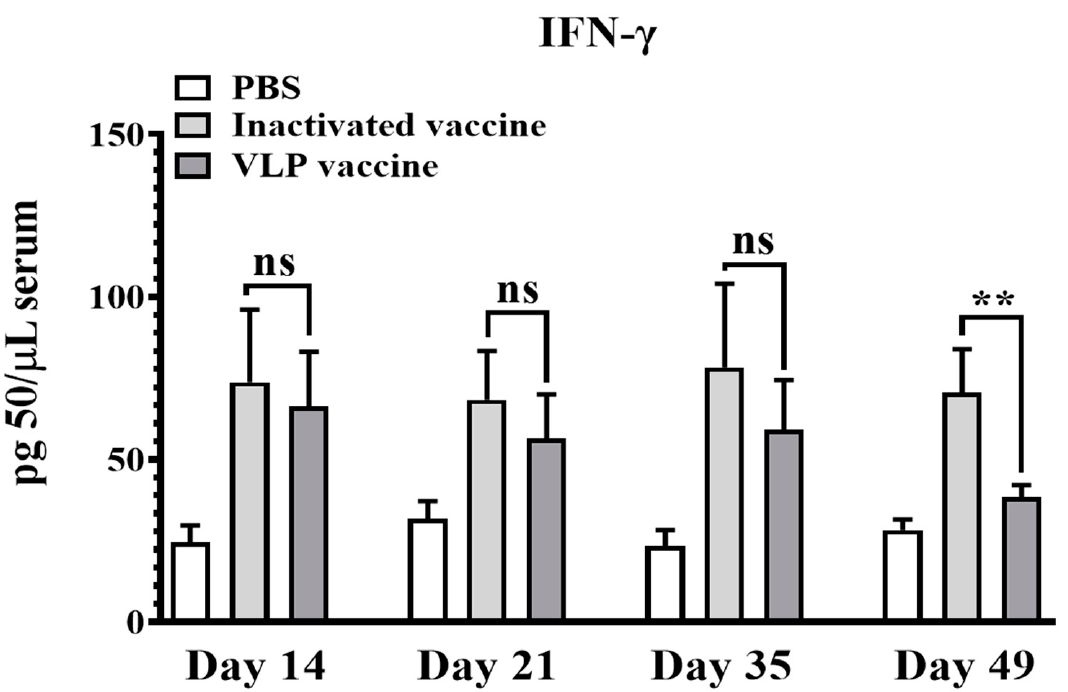
Figure 4. Detection of serum INF- γ . Serum collected from pigs vaccinated with SVA VLPs ( n = 5), inactivated vaccines ( n = 5) and PBS ( n = 5) at 0 days, 14 days, 21 days, 35 days and 49 days post-immunization. INF- γ titers represent the intensity of cellular immune response (ns were considered no statistically significant, ** p <